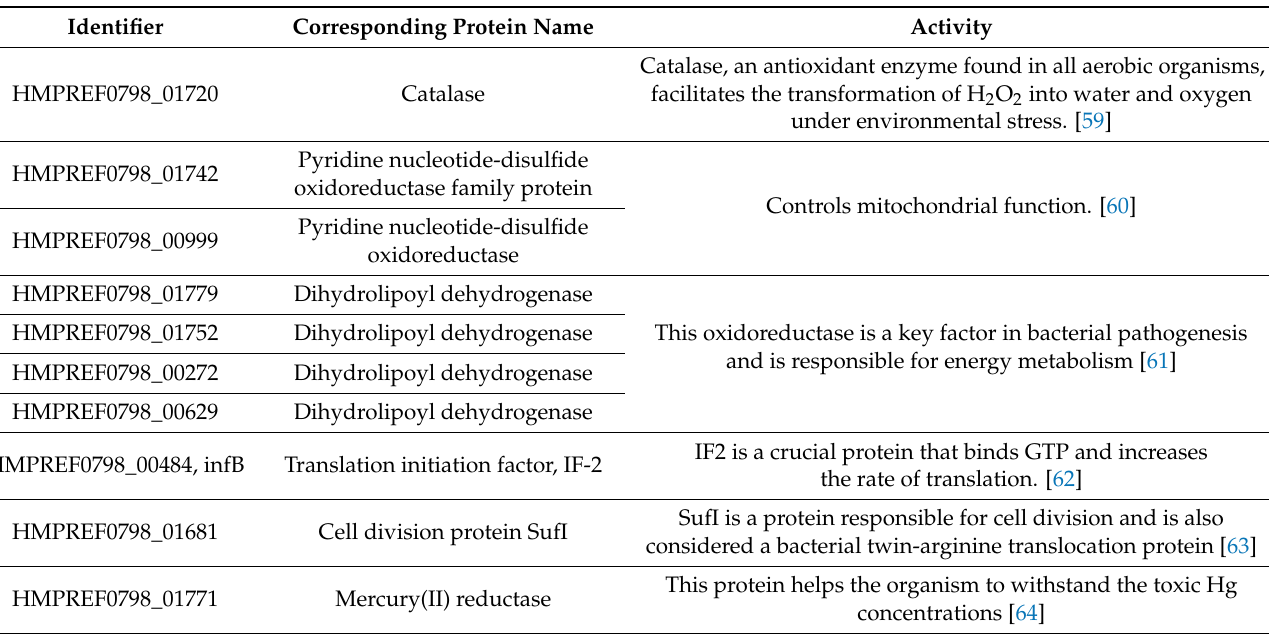
Table 1. Effect of citrate functionalized CuO NPs on S. hominis bacterial